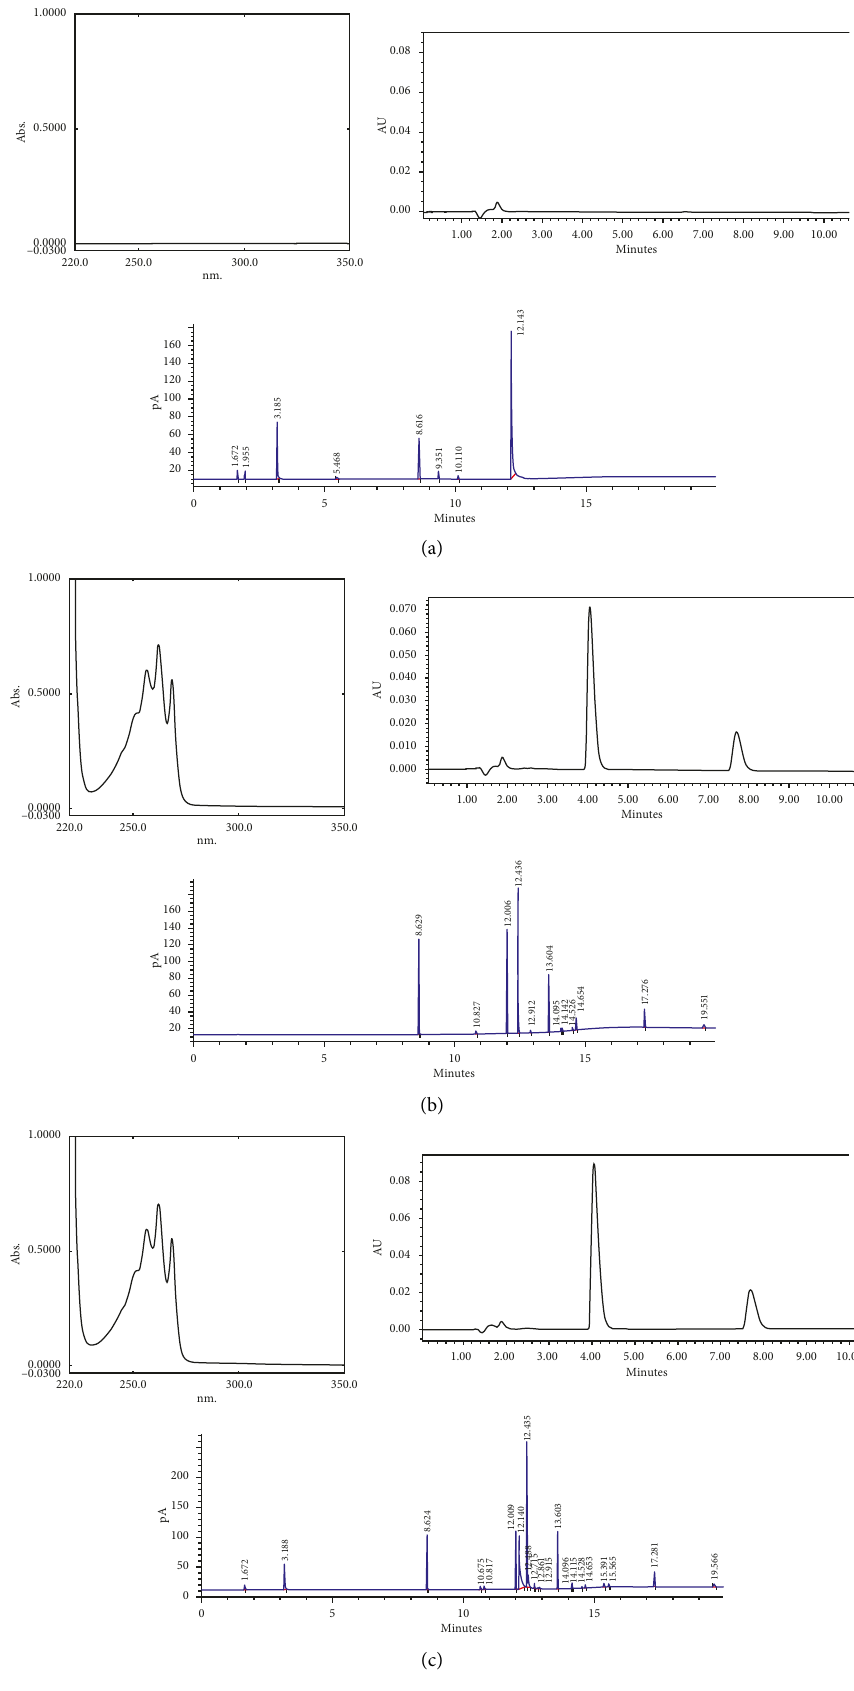
Figure 2: Electronic absorption spectra and chromatograms of blank (a), standard (b), and sample (c) solutions of the UV (1), HPLC (2), and GC (3) in the determination of